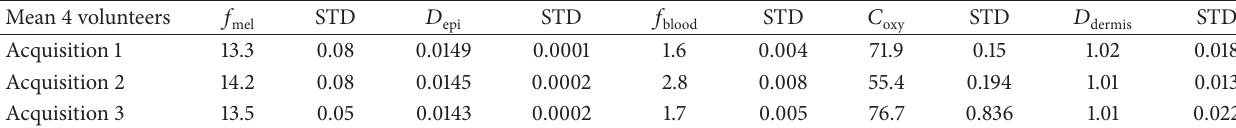
Table 8: Mean parameters estimation for the data acquired on 4 healthy volunteers.